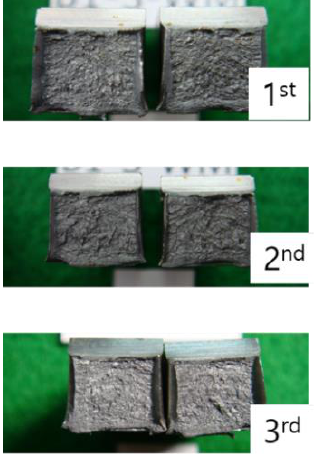
Figure 8. Specimens of Charpy impact test at − 40 °C.